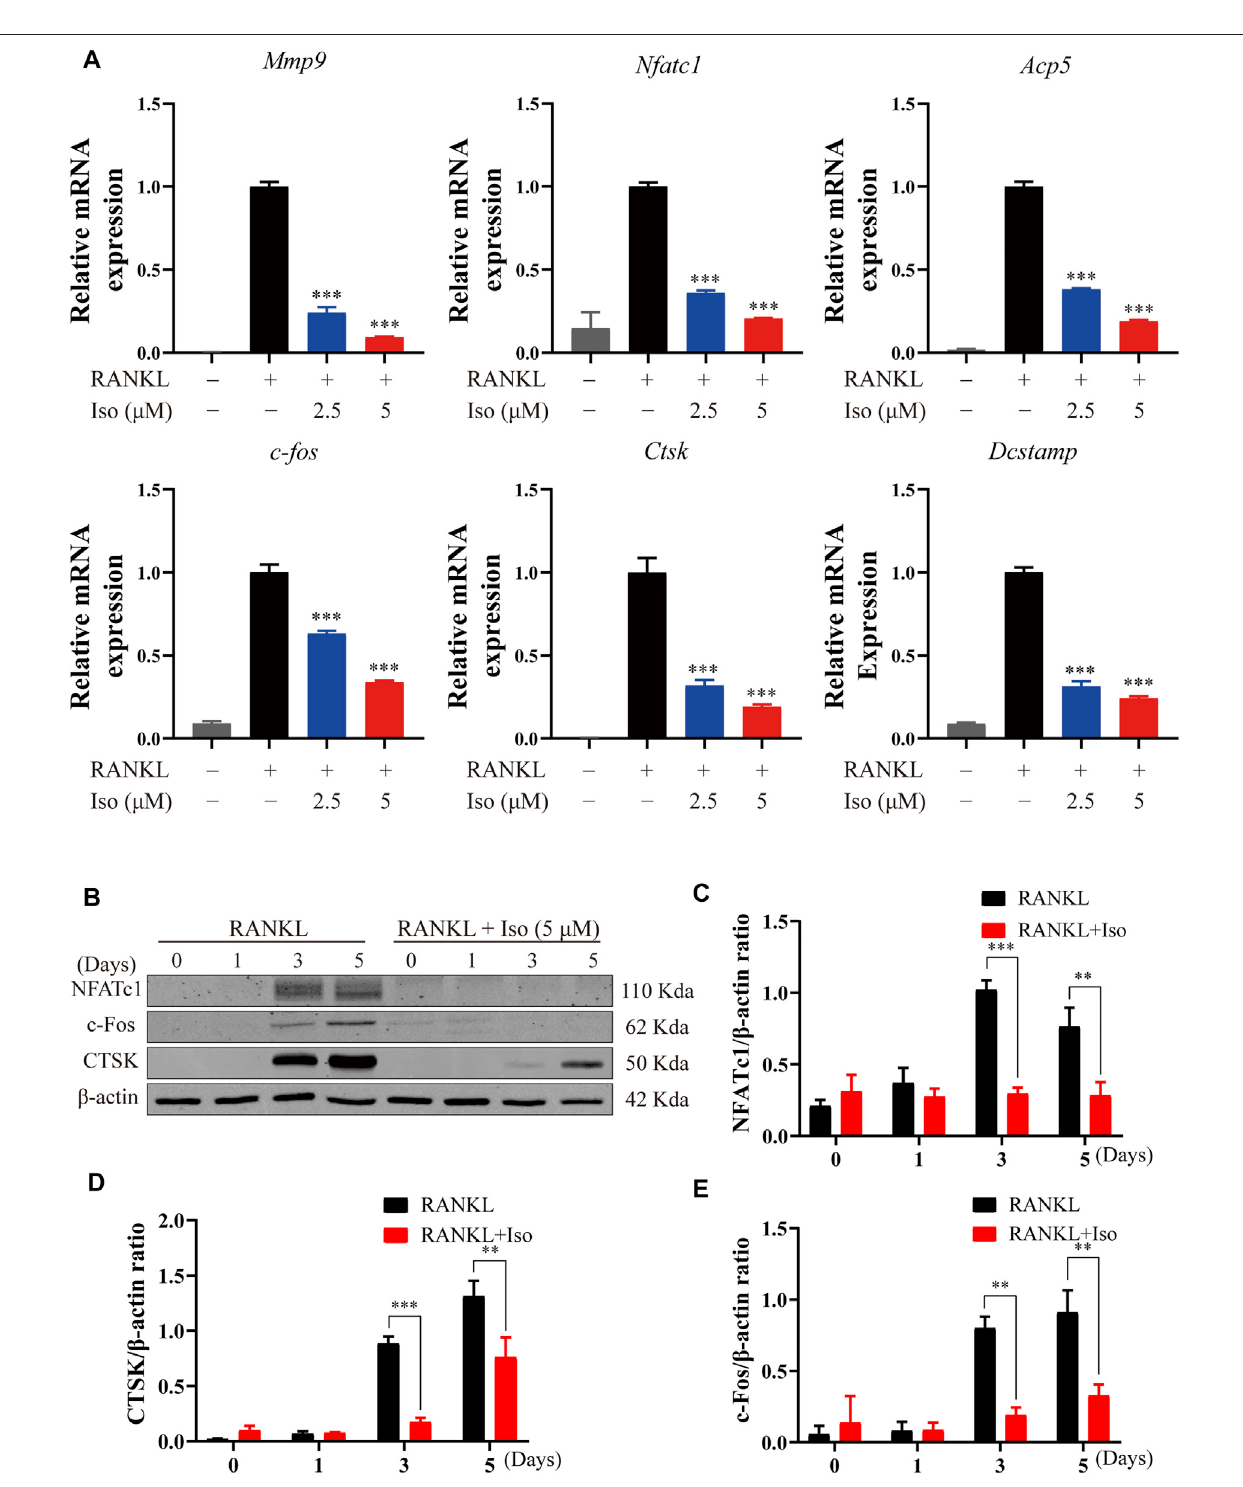
FIGURE 4 | Iso inhibits osteoclast marker gene expression and attenuates c-fos, CTSK and NFATc1 protein expression. (A) BMMs were treated with M-CSF (25 ng/ml) and RANKL (50 ng/ml) in the presence or absence of the indicated concentrations of Iso. Gene expression was normalized to Hmbs. qPCR analysis of osteoclast-speci fi c genes expression of Mmp9, Nfatc1, Trap, C-fos, Ctsk And Dc-stamp ( n = 3 per group). (B) BMMs were treated with or without Iso (5 μ M) on day1, day3, day5 and the proteins including c-Fos, NFATc1 and CTSK were measured using western-blot (C – E) The expression of proteins mentioned above was quantitatively analyzed related to β -actin. * p < 0.05, ** p < 0.01, *** p < 0.001. BMMs, bone marrow macrophages; Iso, Isoliensinine; PCR, polymerase chain reaction; RANKL, receptor activator of nuclear factor- κ B ligand; M-CSF: macrophage colony stimulating factor; Mmp9 , matrix metallopeptidase 9; Nfatc1 , nuclear factor of activatedTcells1; Trap ,tartrate-resistantacidphosphatase; c-fos ,Proto-oncogeneC-Fos; Ctsk ,cathepsinK; Dc-stamp ,dendriticcell-speci fi ctransmembraneprotein.